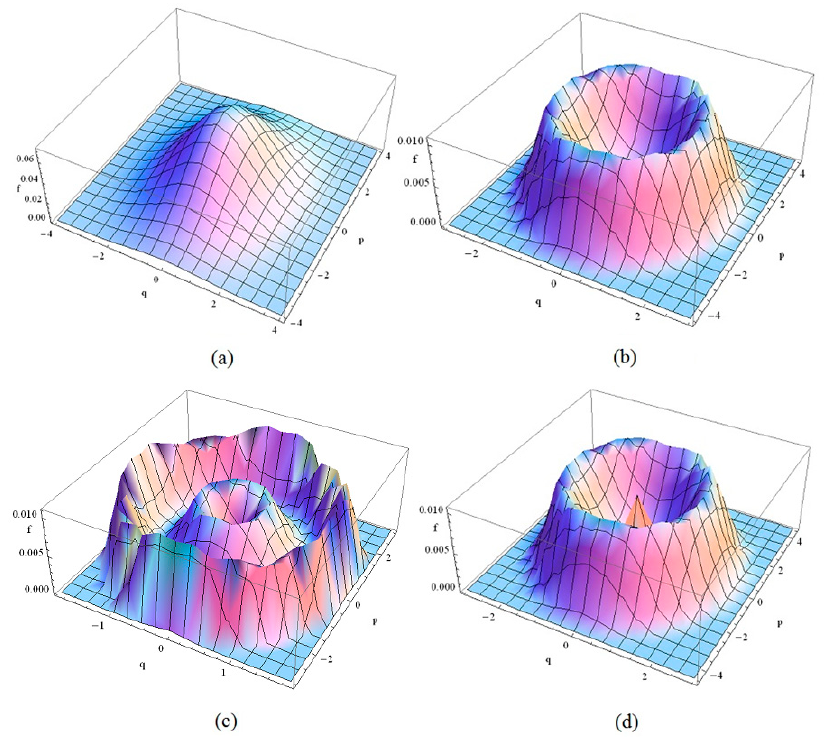
Figure 2. Stationary probability density of the system response. ( a ) D = 0.1; ( b ) D = 0.4; ( c ) D = 0.6; ( d ) D =